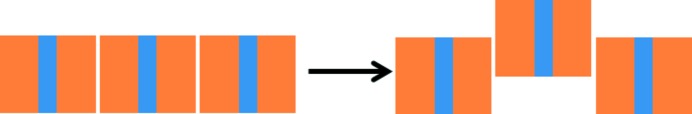
Schematic of the typical bilayer displacement during solid-state phase transitions in linear-chain amino acids.